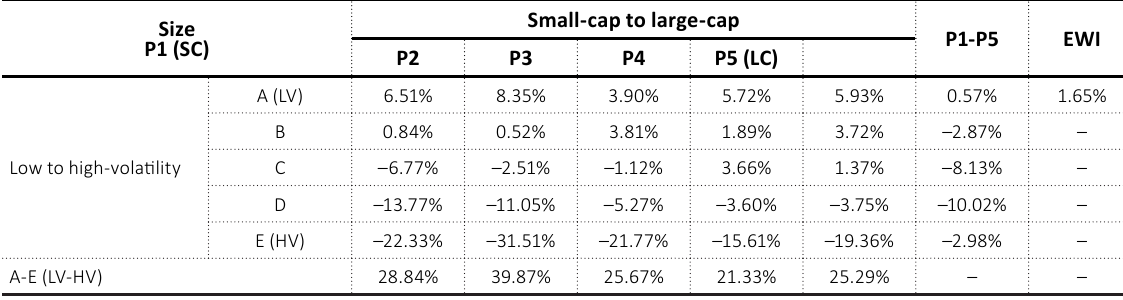
Table 4. Excess returns of independent sort portfolios on size and